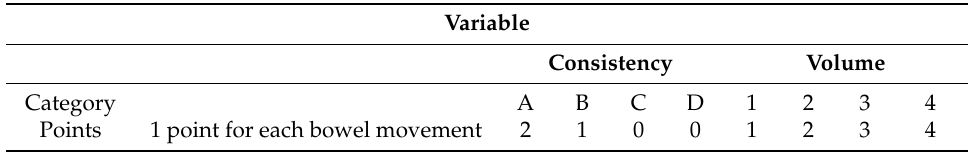
Table 2. Total score of severity of diarrhoea based on Amsterdam stool